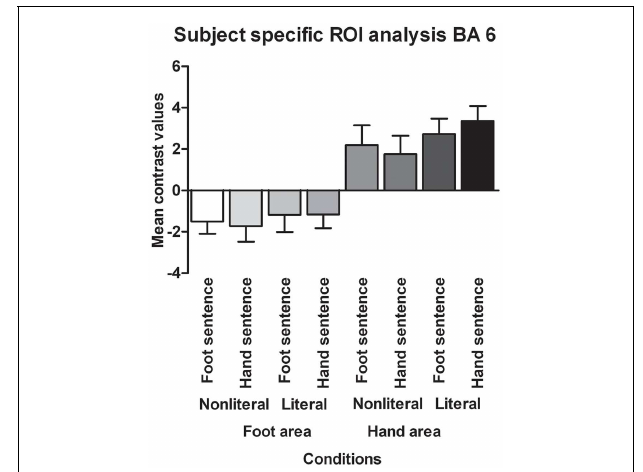
FIGURE 4 | Functionally defined, subject-specific ROI analysis for the foot area and hand area in BA 6. The mean contrast values compared to an implicit baseline are shown for each sentence type and